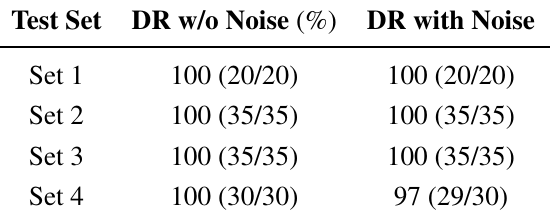
Table 3. Detection rate (DR) of the horizon for the noiseless data and noisy data.